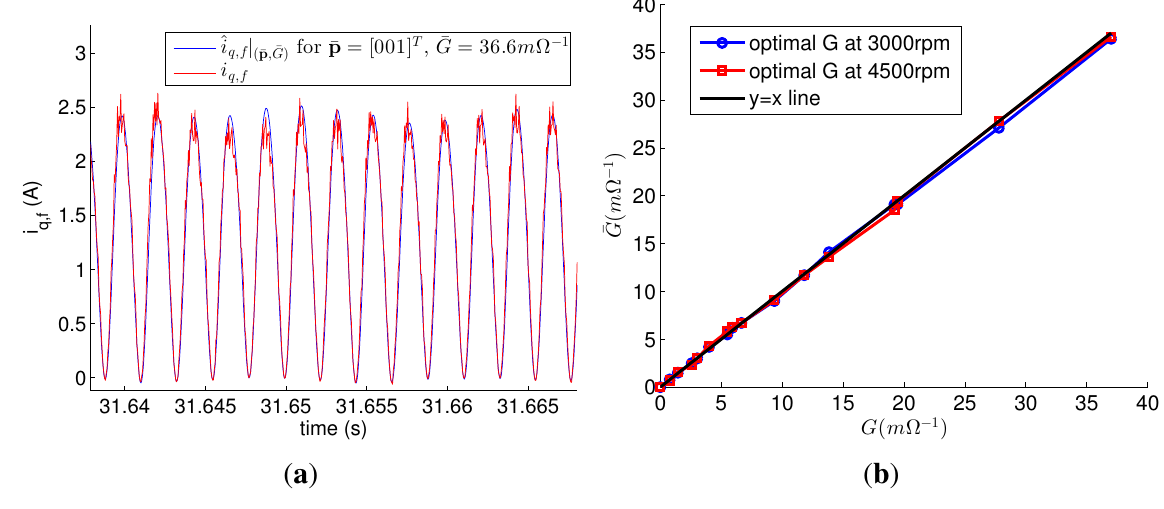
| Figure 7. ( a ) ˆ i for ¯ p = [0 0 1] T , ¯ G = 36 . 6 m Ω − 1 , and the measurement data i q,f ¯ p , ¯ G faulty motor under the fault p = [0 0 1] T , G = 37 . 0 m Ω − 1 ; ( b ) Optimal ¯ G for the